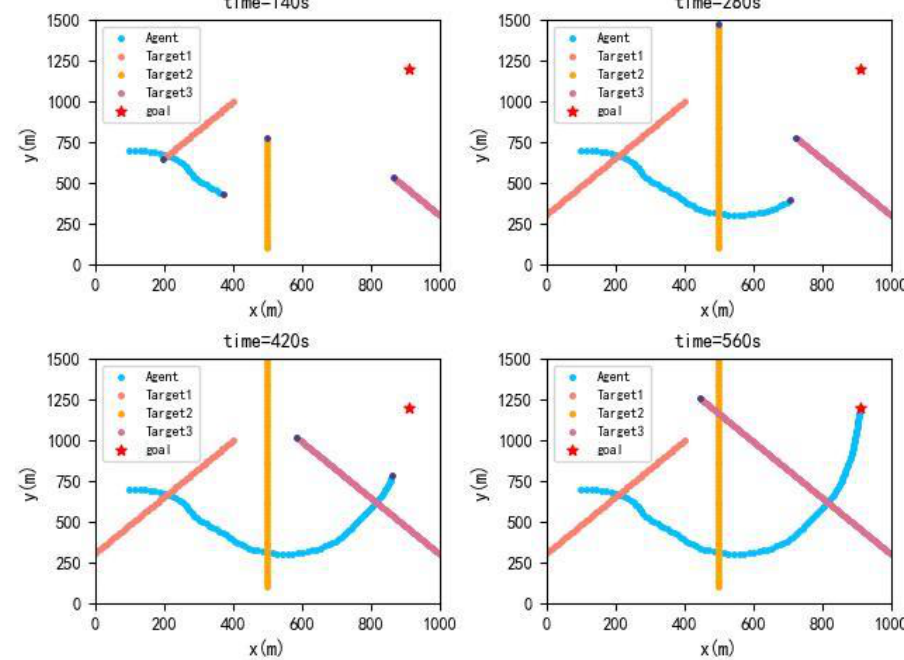
Figure 7. Trajectories when 𝑤 = 0.1.